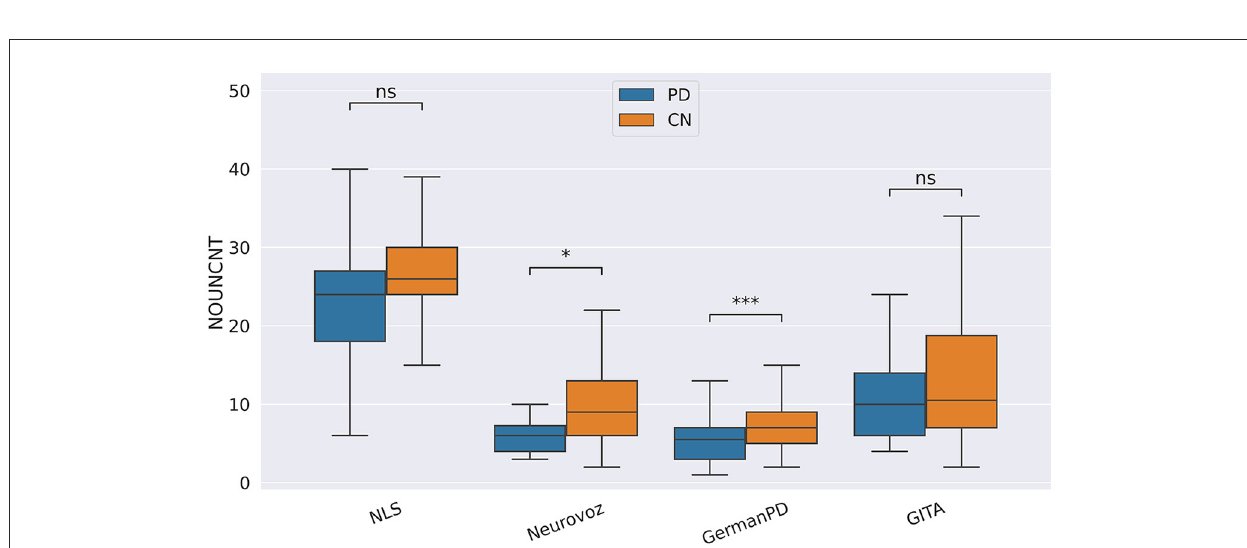
FIGURE4 Boxplots with statistical annotations representing the noun count (NOUNCNT) on NLS, Neurovoz, GermanPD, and GITA from the SS task. Horizontal lines represent the median, the top ends represent the upper quartile, and the bottom ends represent the lower quartile. Statistically significant differences between groups after Benjamini–Hochberg correction for NOUNCNT are reported in Table 6 and highlighted below using asterisks. NOUNCNT, noun count; CN, controls; PD, Parkinson’s disease; SS, spontaneous speech; ns, not